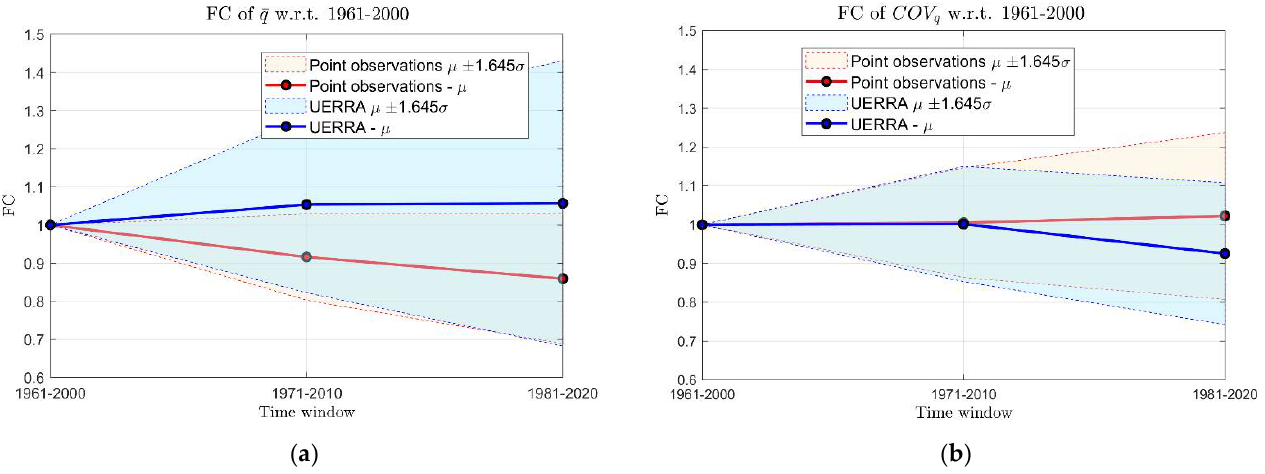
Figure 16. Factors of change for mean ( a ) and COV q ( b ) of annual maxima ground snow load, comparison between observations and regional reanalysis at the test stations.